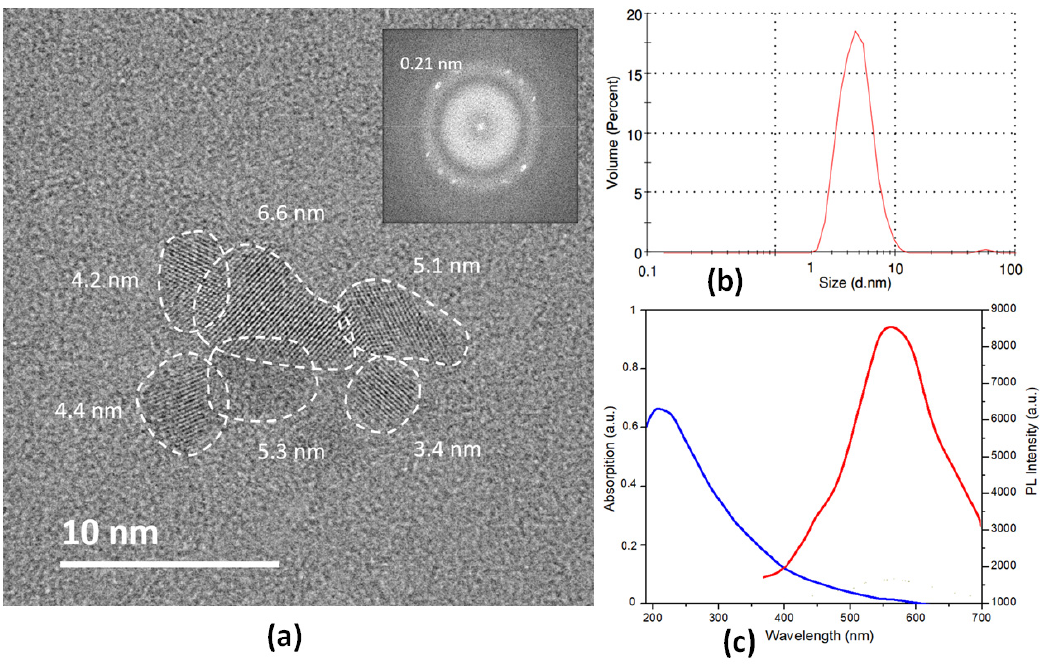
Figure 2. ( a ) Representative HRTEM image of a GQDs cluster with mean particle size of 4.8 nm and the corresponding fast Fourier transform (FTT) on the inset showing planes at 0.21 nm; ( b ) DLS measurement of GQDs dispersion in deionized water; ( c ) optical properties of GQDs dispersions in deionized water: UV—vis absorption spectrum of GQDs (blue line) and photoluminescence (PL) spectrum of GQDs at the excitation wavelengths of 360 nm (red line).